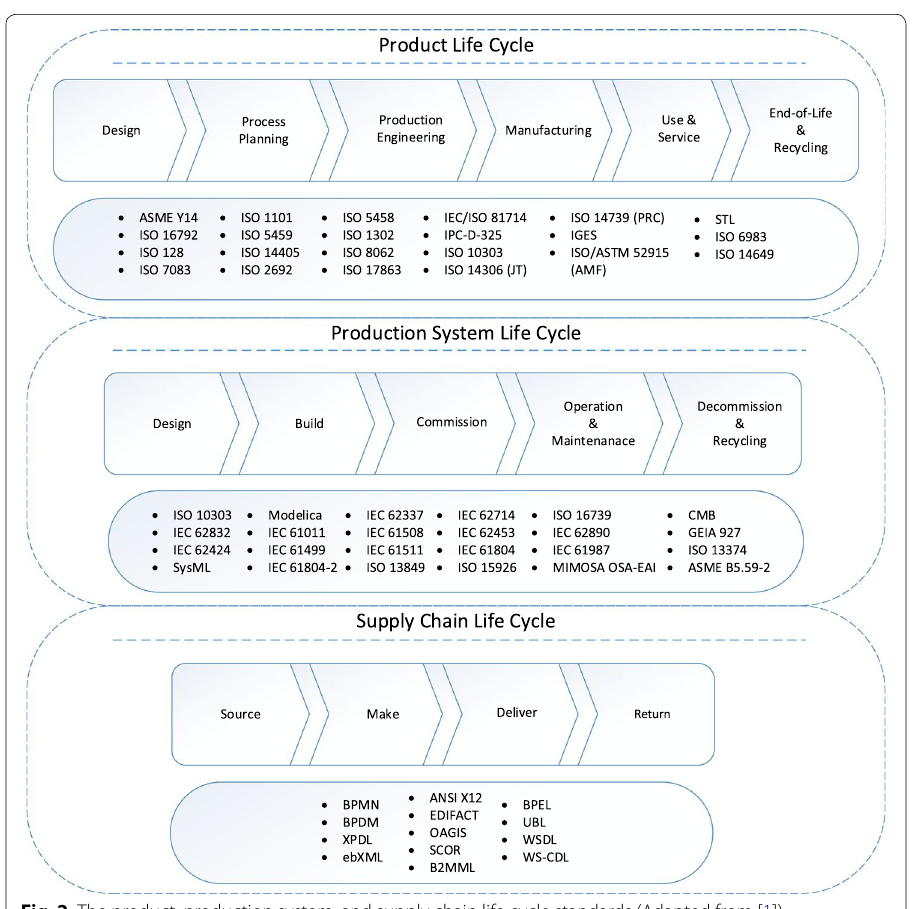
Fig. 2 The product, production system, and supply chain life cycle standards (Adapted from